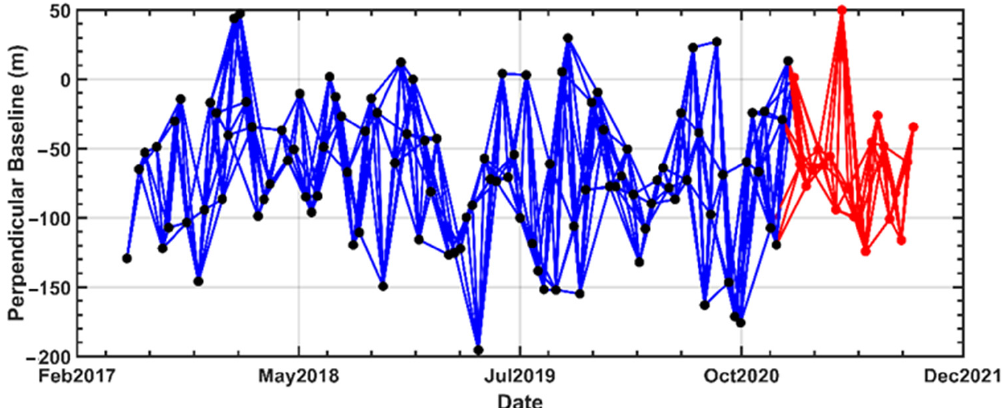
Figure 3. Temporal and perpendicular baseline combination of SAR interferograms. The blue lines indicate interferograms generated between archived SAR images in the first group by the SBAS- InSAR method, and the red lines show the new interferograms generated between the newly received SAR images and older archived SAR images for the sequential estimation.